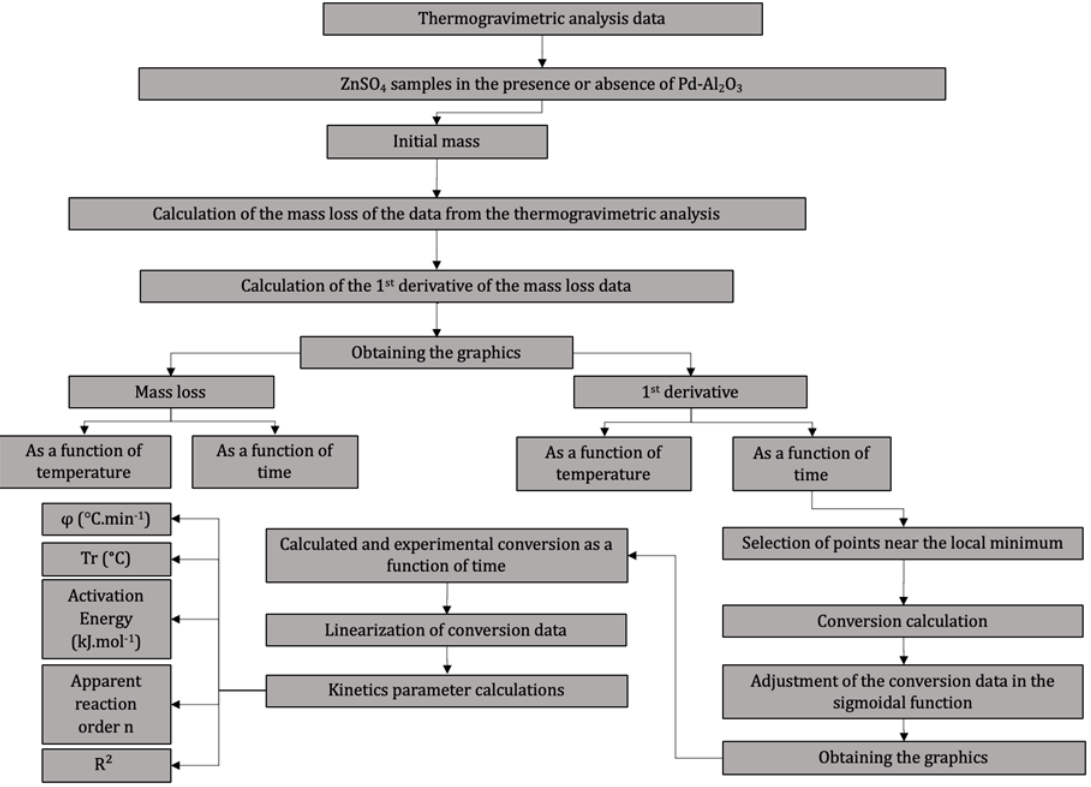
Figure 1. Flowchart describing the modeling algorithm for the calculations of the kinetic parameters. Thermogravimetric analyses of zinc sulfate monohydrate thermal decomposition were performed to measure the conversion achieved as a function of time during dynamic runs conducted under a N 2 atmosphere (20 mL · min − 1 ) at a heating rate of 10 ◦ C · min − 1 . The TGA tests were conducted in a Netzsch instrument model STA 449 F3 Jupiter and covered a temperature range from 25 to 1000 ◦ C. Around 5 mg of pure sulfate (P.A., Sigma-Aldrich, St. Louis, MO, USA) and mixtures with Pd/Al 2 O 3 were used, using a 1:1 mass ratio between sulfate and catalyst in the latter case. The Pd/Al 2 O 3 catalyst was prepared following the methodology presented by Mello [43]. The kinetic modeling carried out in the present work was based on Equation (1) [44,45], where Tr, ϕ , and f represent the reference temperature, heating rate, and thermal decomposition conversion at a specific time ( t ), respectively.